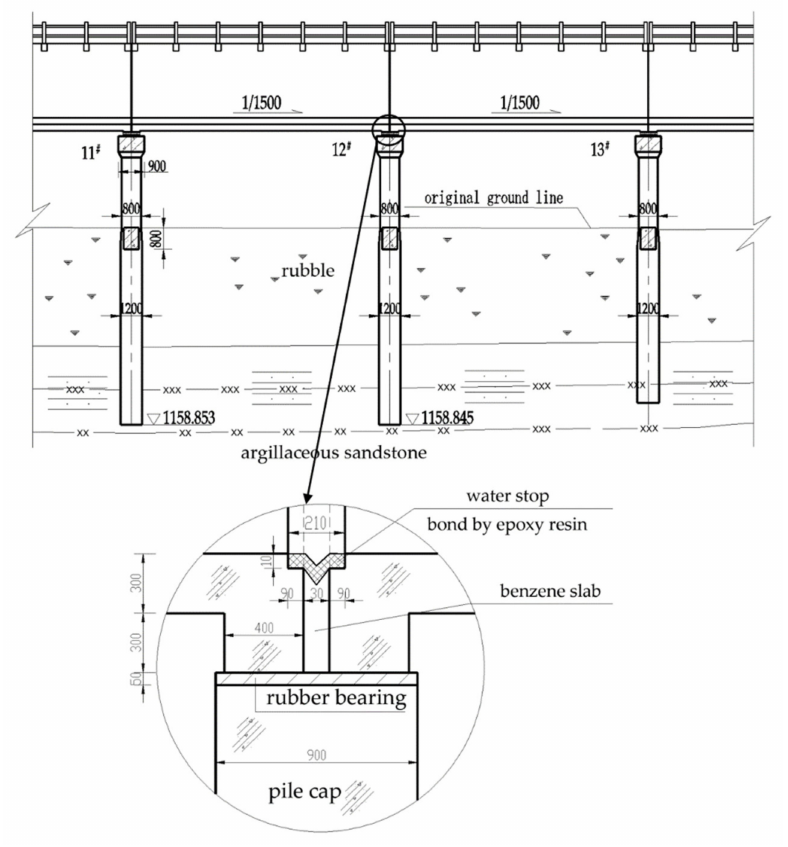
Figure 1. Elevation of the aqueduct and the layout of the water stop (unit: